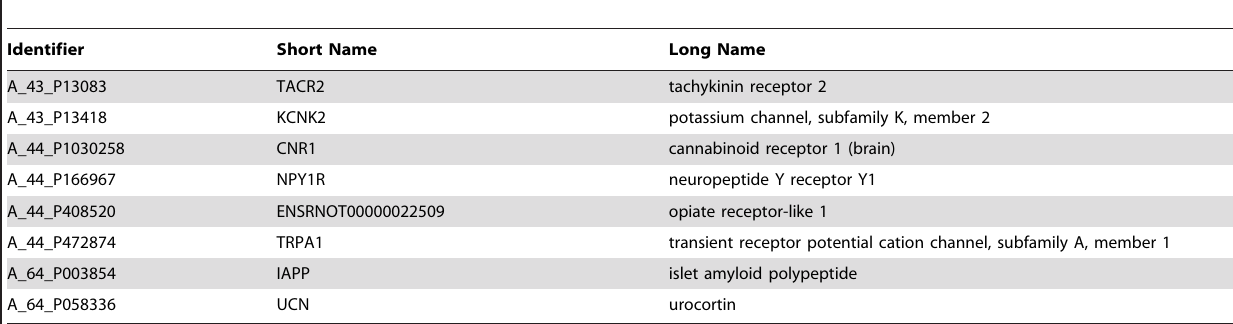
Table 6. Upregulated genes specifically involved in pain transmission in VSL # 3-treated NMS rats in comparison with not treated NMS animals.